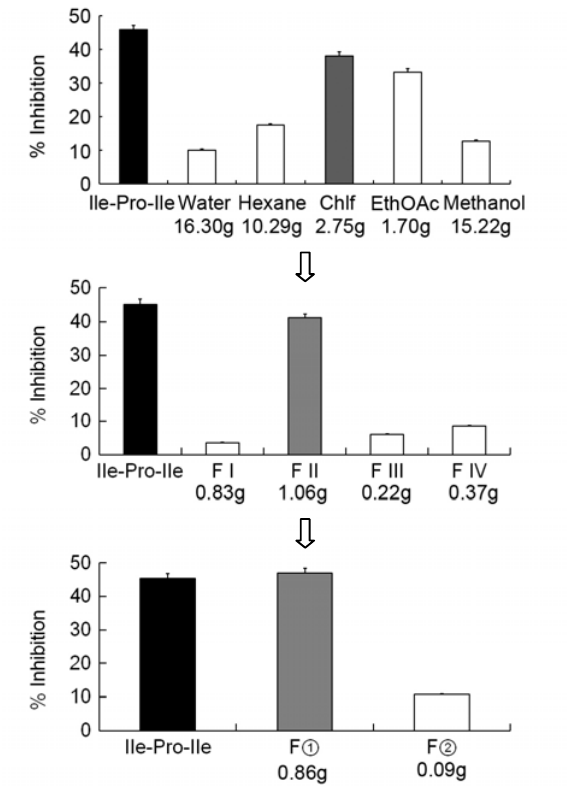
Figure 1. Activity-guided purification of the chloroform extract of mycelium powders. Gray represents active site. F: fraction. The results are expressed as the mean ±